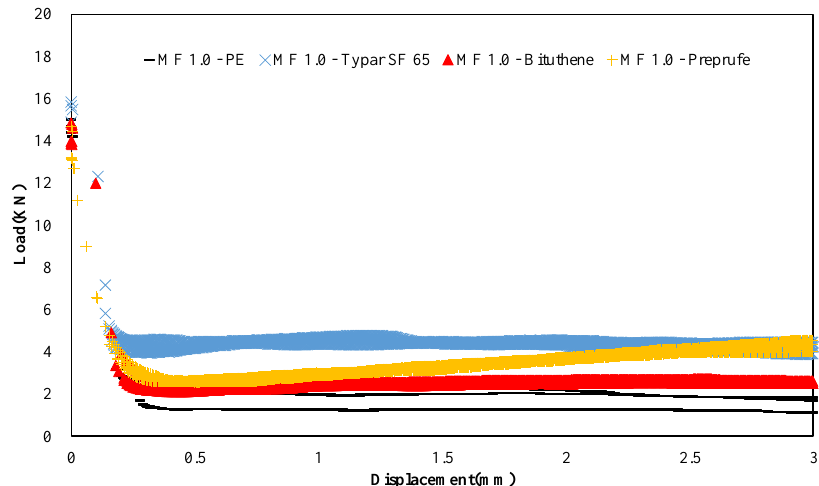
Figure 4. Load-displacement curve during crack propagation (SF 20). Figure 4 . Load-displacement curve during crack propagation (SF 20). Figure 4 . Load-displacement curve during crack propagation (SF 20).